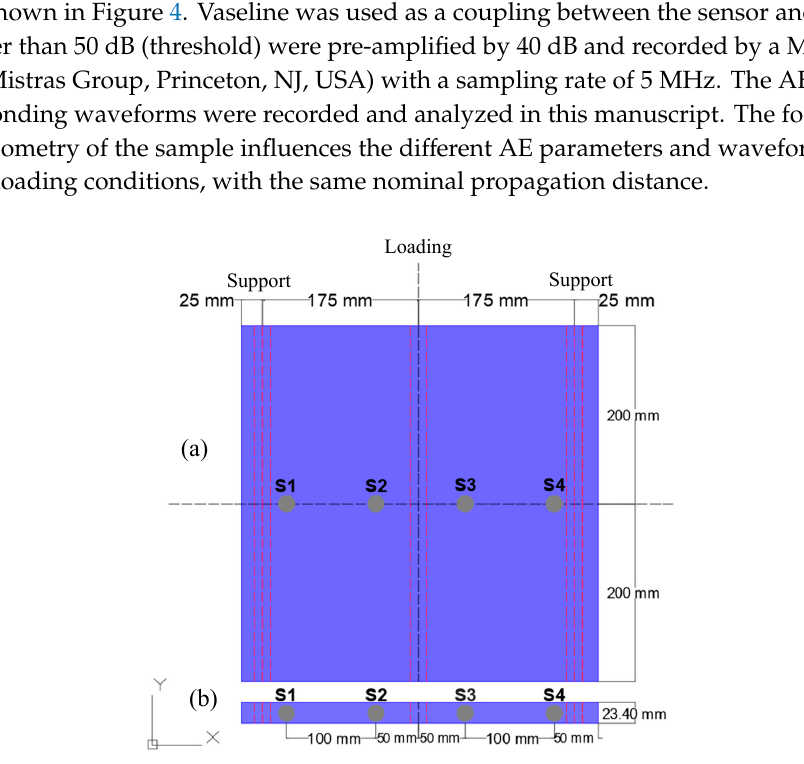
Figure 4. Schematic representation of three-point bending loading points and supports, and sensors distribution for both: ( a ) TRC plate and ( b ) TRC beam. S1 to S4 stand for AE